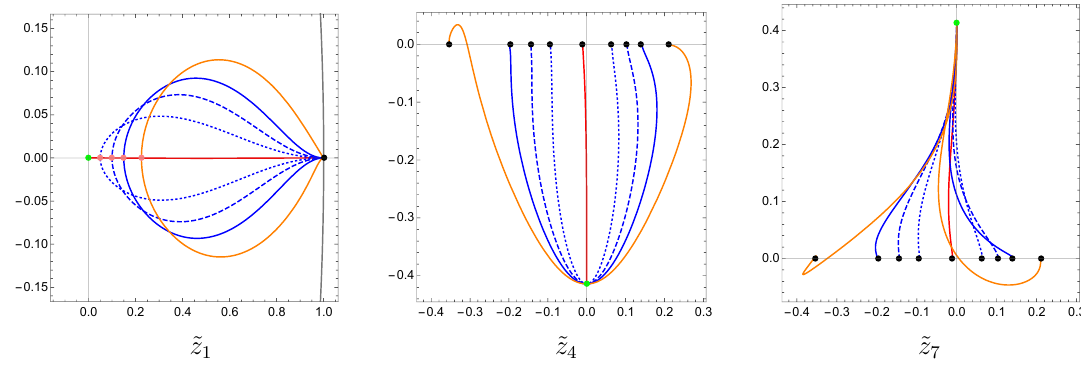
Figure 7 . Samples of regular flows within the SO(3) -invariant sector using the boundary condi- tions (3.34) for the complex scalar fields ˜ z AdS 4 vacuum and the D3-brane asymptotics are denoted by green and black dots, respectively. The grey line in the left plot corresponds to the boundary values | ˜ z to the choice (cid:15) ≈ 0 whereas the orange one corresponds to (cid:15) ≈ (cid:15) right plots are compatible with SO(6) invariance, i.e. ˜ z values ± Φ of the type IIB dilaton in the D3-brane asymptotics at r → ±∞ . 0 conditions (3.31) localise the flows in the real axis both for ˜ z